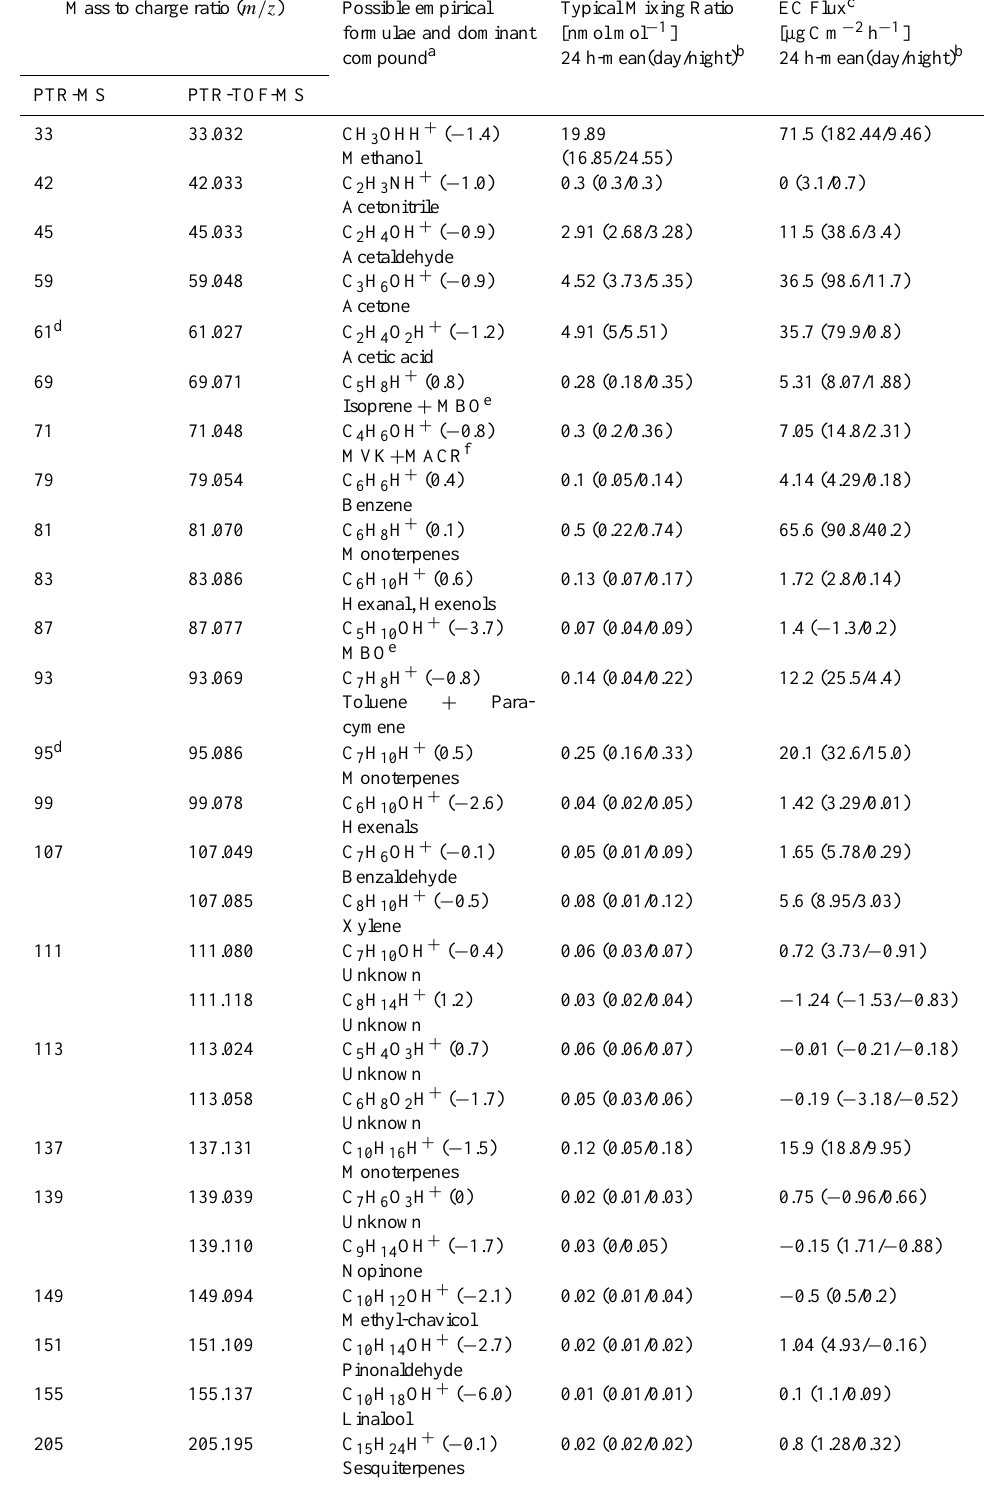
Table 2. Mixing ratio and flux information for 27 selected ion